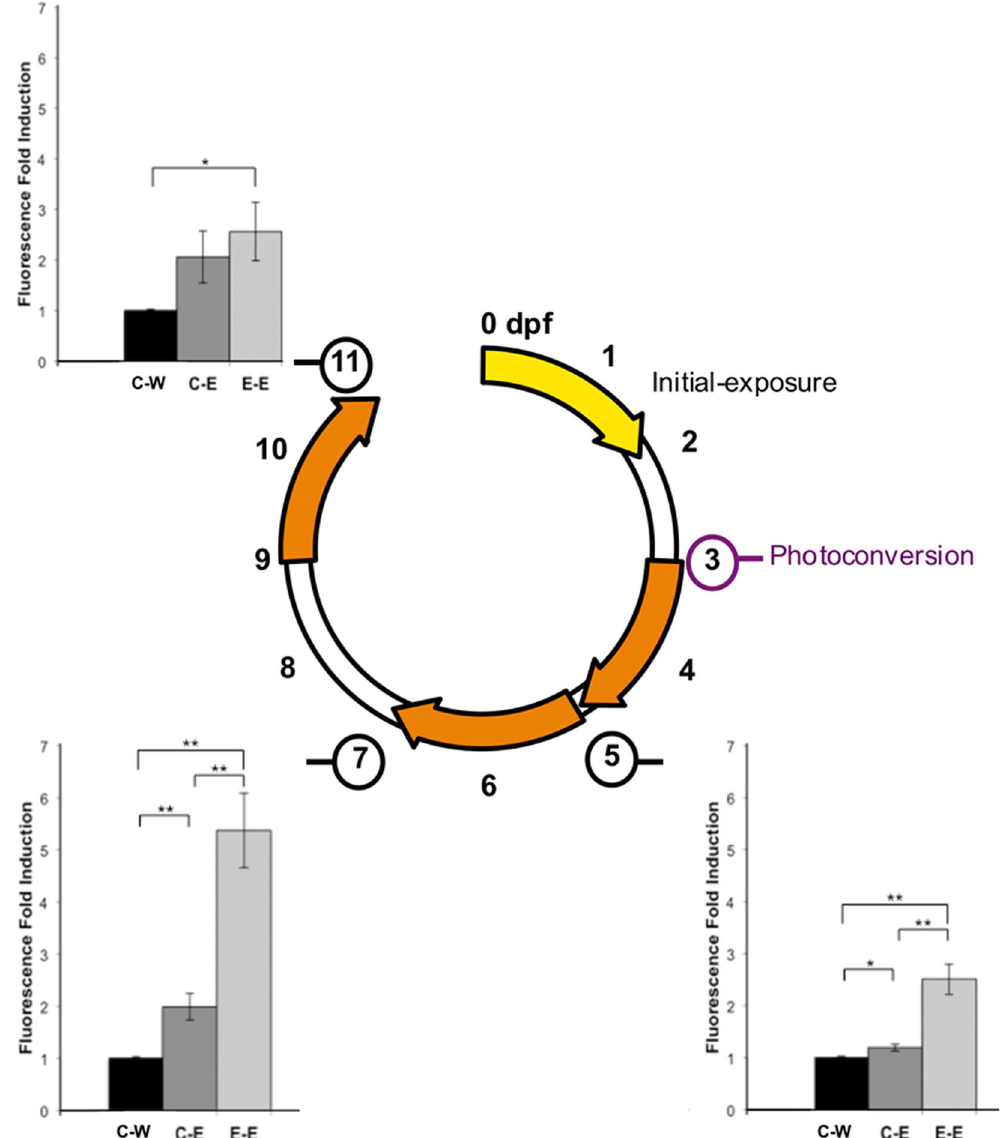
Figure 4. Quantification of liver responses in ERE-Kaede-Casper transgenic zebrafish exposed to EE2 at different stages of development, as determined by fluorescence induction. Responses in the liver were quantified after EE2 exposure at 3–5 dpf, 5–7 dpf and 9–11 dpf. Quantification of liver responses in the E-Chemical treatment groups were normalized against their respective controls. Data are reported as mean fold induction ± SEM (n = 18). Statistical significance values were calculated using ANOVA and Games-Howell post-hoc test ( * p < 0.05 and ** p <